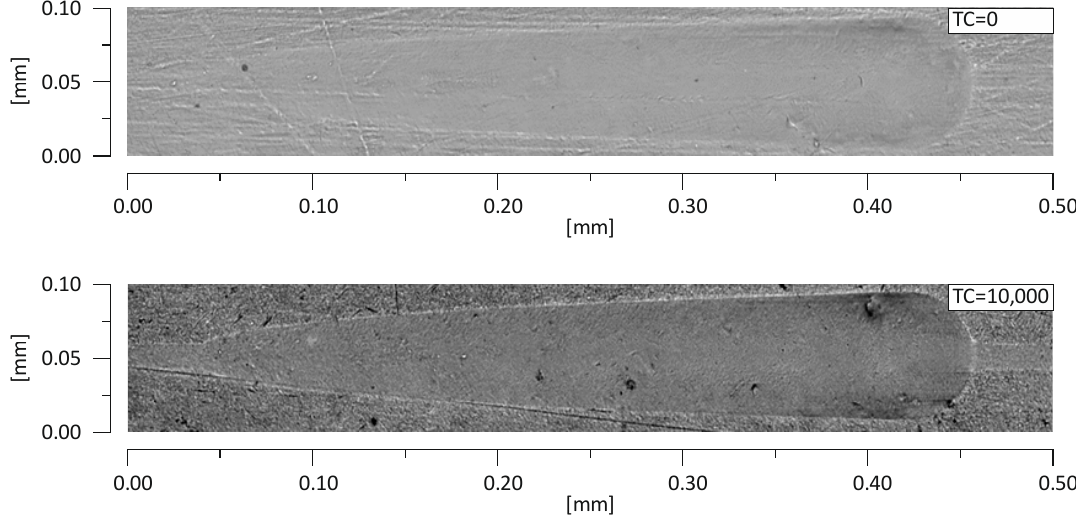
Figure 9. Scratches on the surfaces of the test specimen Ex-nano (G) with aging only (0 TC) and after thermal fatigue (10,000 TCs).